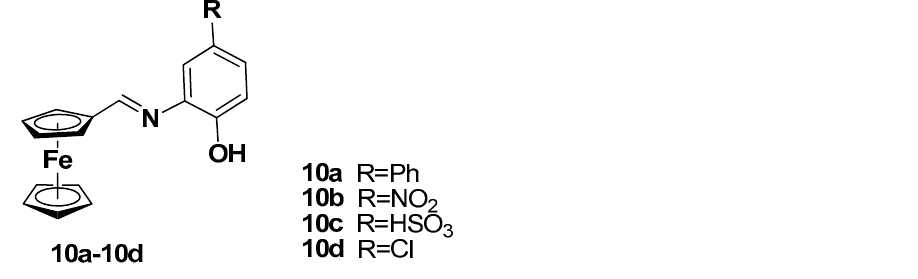
Figure 5. Ferrocenes Schiff base derivatives have been studied by molecular docking as anti-coronavirus agents. Table 3. Docking simulation results with Docking Score Energy. Binding energy (BE) between ferrocenes 10a–10d , drugs, and 6LU7 Protein of SARS-CoV-2; data from [16]. Compound